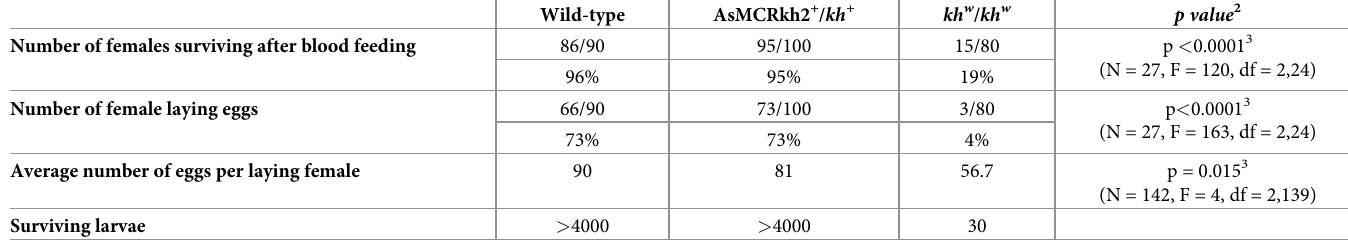
Table 3. Impact of ablations of the kynurenine hydroxylase gene on females Anopheles stephensi following a blood meal 1